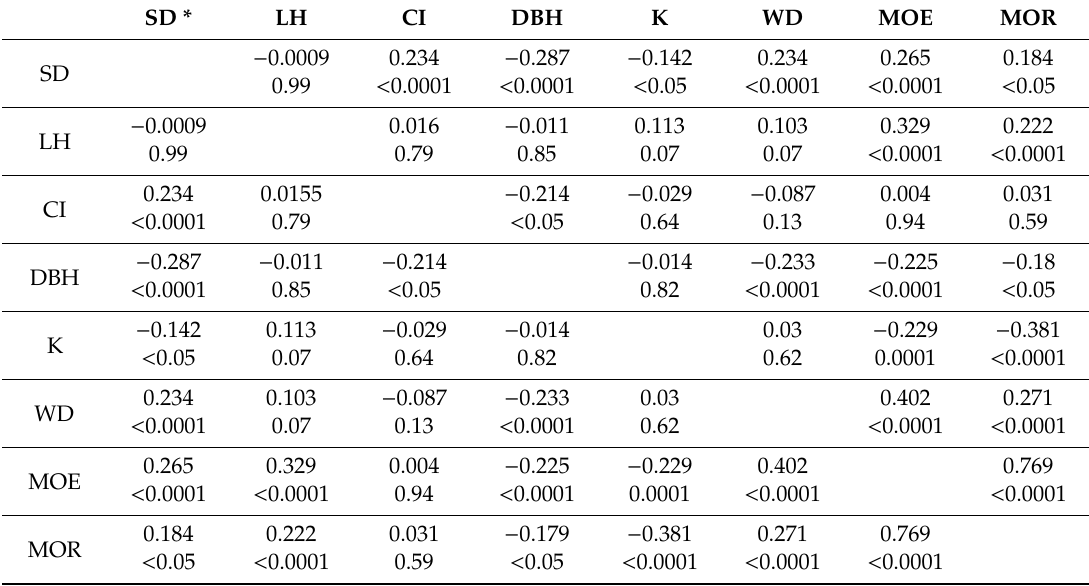
Table 5. Correlation coe ffi cients and probability (the line below) among tree characteristics and wood quality parameters for the model Norway spruce trees, n = 310.